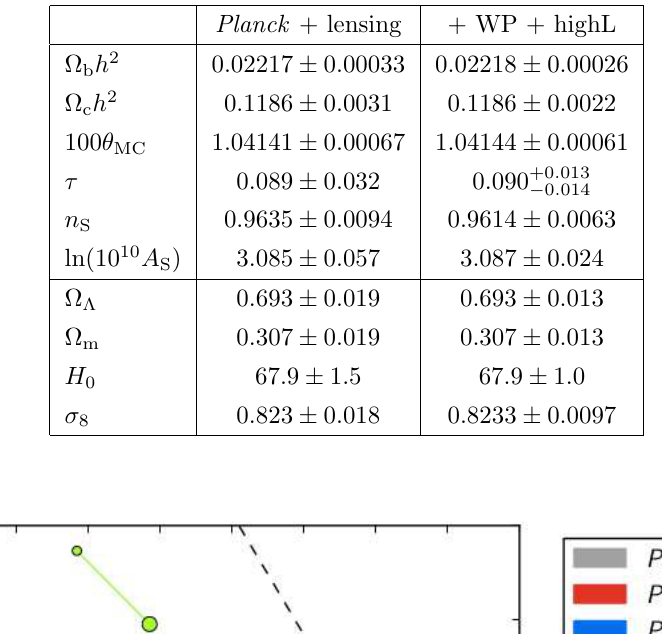
Table 2: Cosmological parameter values for the six-parameter base ΛCDM model. Column 2 give the results for the Planck temperature and lensing potential power spectra, while column 3 adds the information from WMAP polarization (WP) at low multipoles ( (cid:96) ≤ 23), and other small scale CMB experiments (highL). See Planck Collaboration XVI 2013 for details. The last four rows are derived parameters.